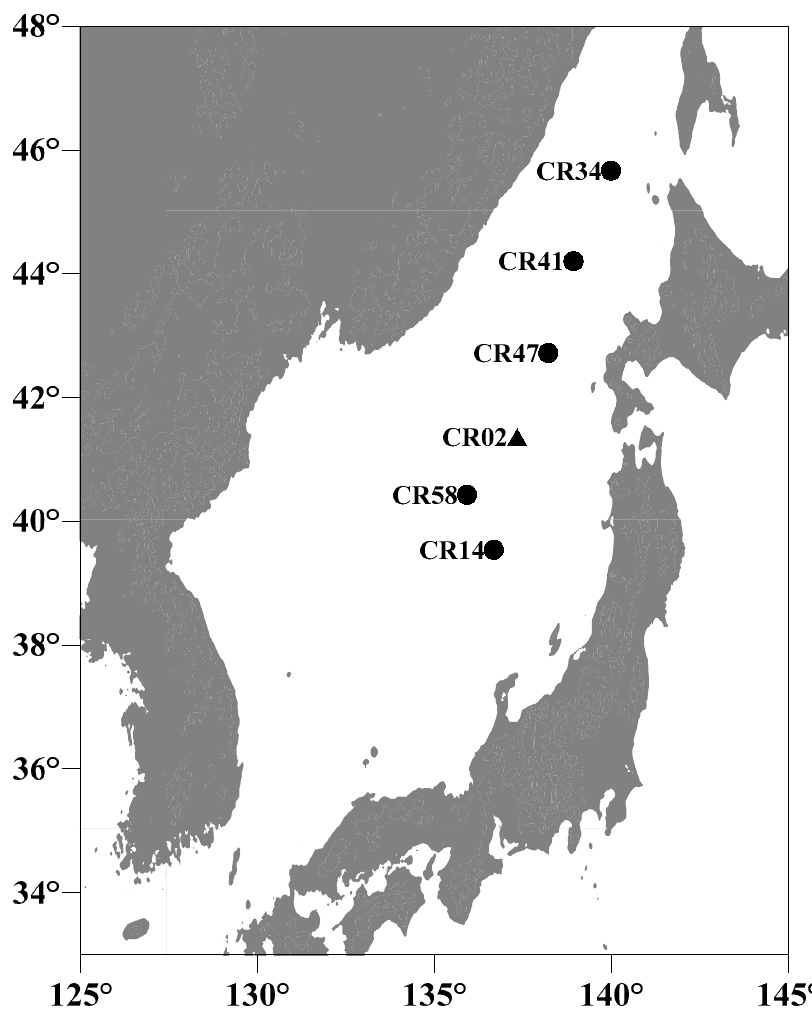
Figure 1. Locations of the hydrochemical and geochemical stations in the Japan/East Sea KH-10-02, 2010.